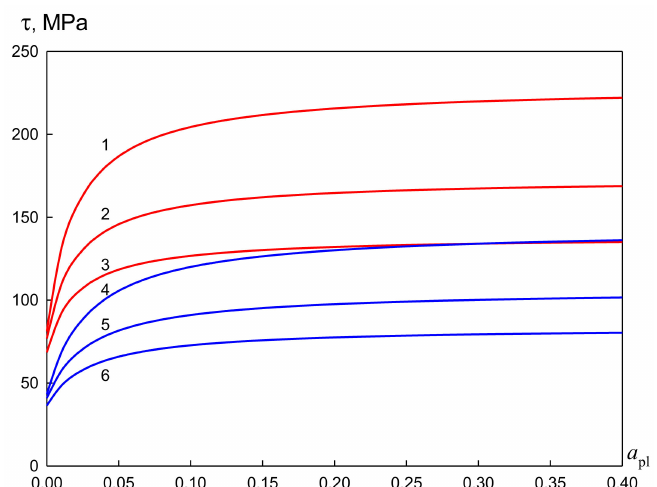
Figure 2. Stress–strain curves for an aluminum-based alloy at various temperatures. Red curves (1–3) correspond to the diameter of strengthening particles, δ = 10 nm, and distances between the particles, Λ p = 100 nm; blue curves (4–6) correspond to the diameter of strengthening particles, δ = 20 nm, and distances between the particles, Λ p = 200 nm. Temperature of deformation on the curves 1 and 4 is T = 293 K, on curves 2 and 5 it is T = 393 K and on curves 3 and 6 it is T = 493 K.